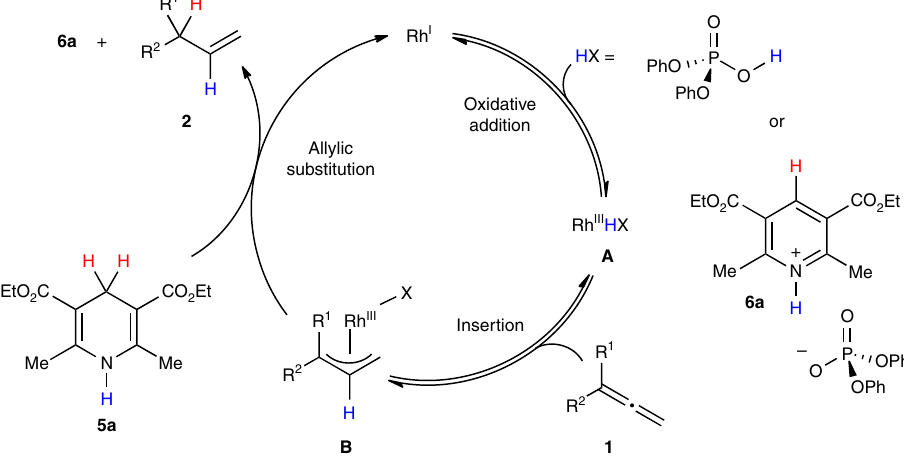
Fig. 6 Proposed mechanism. Mechanistic pathway of the allene